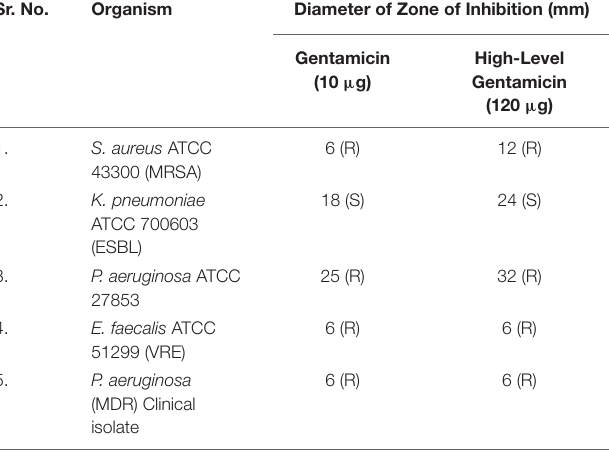
TABLE 1 | MIC of nanoparticles against range of pathogenic bacteria. Sr. No.